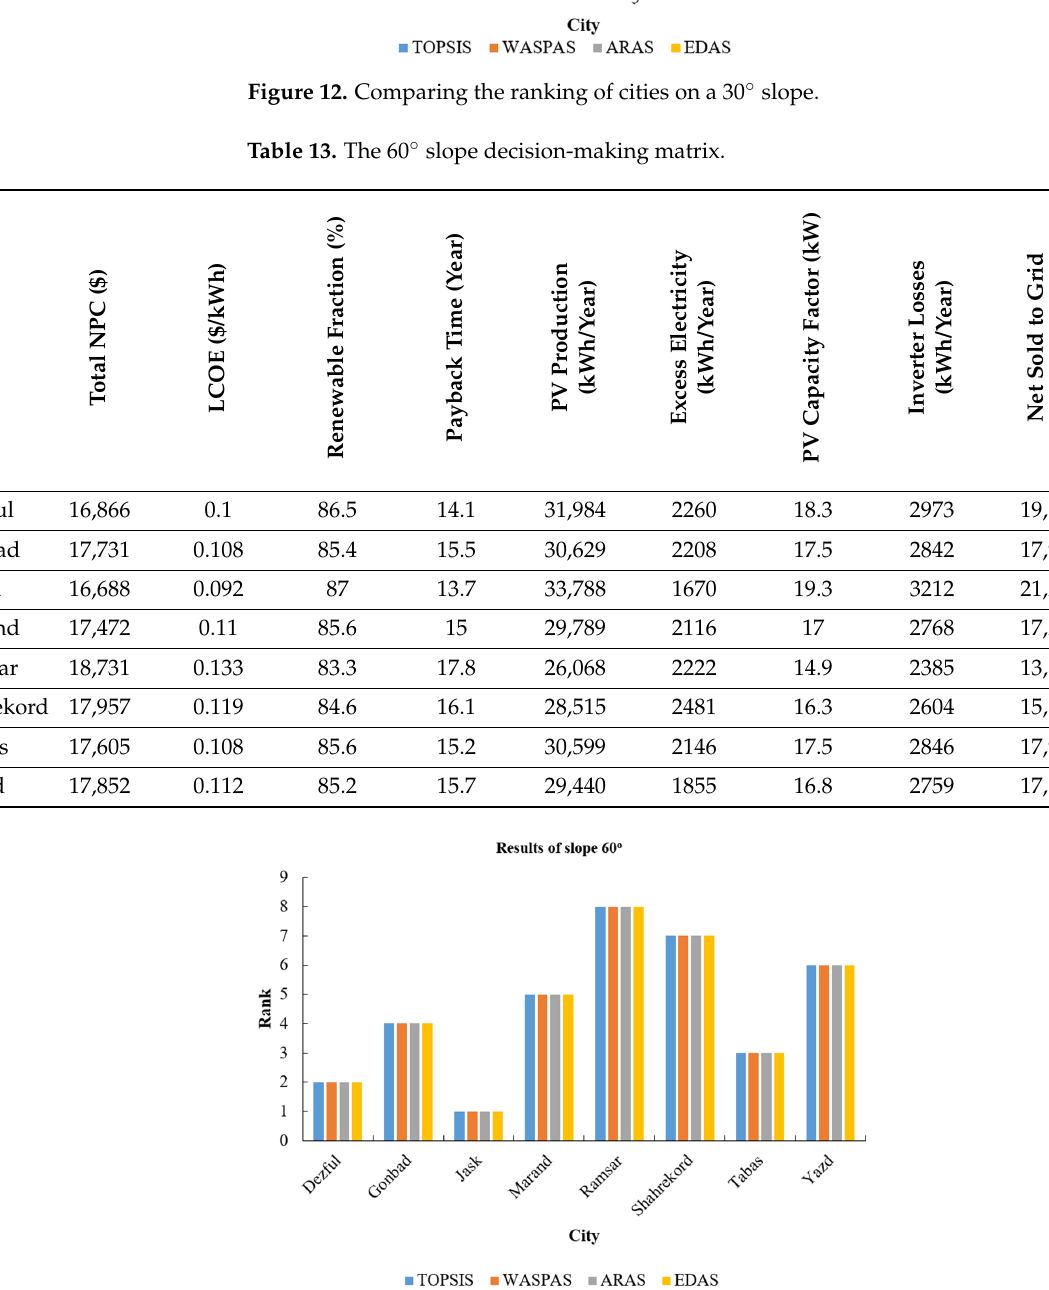
Figure 13. Comparing the ranking of cities on a 60° slope. The decision-making matrix was created to rank the cities on a 90° slope; the results are provided in Table 15. Table 15. The 90° slope decision-making matrix.